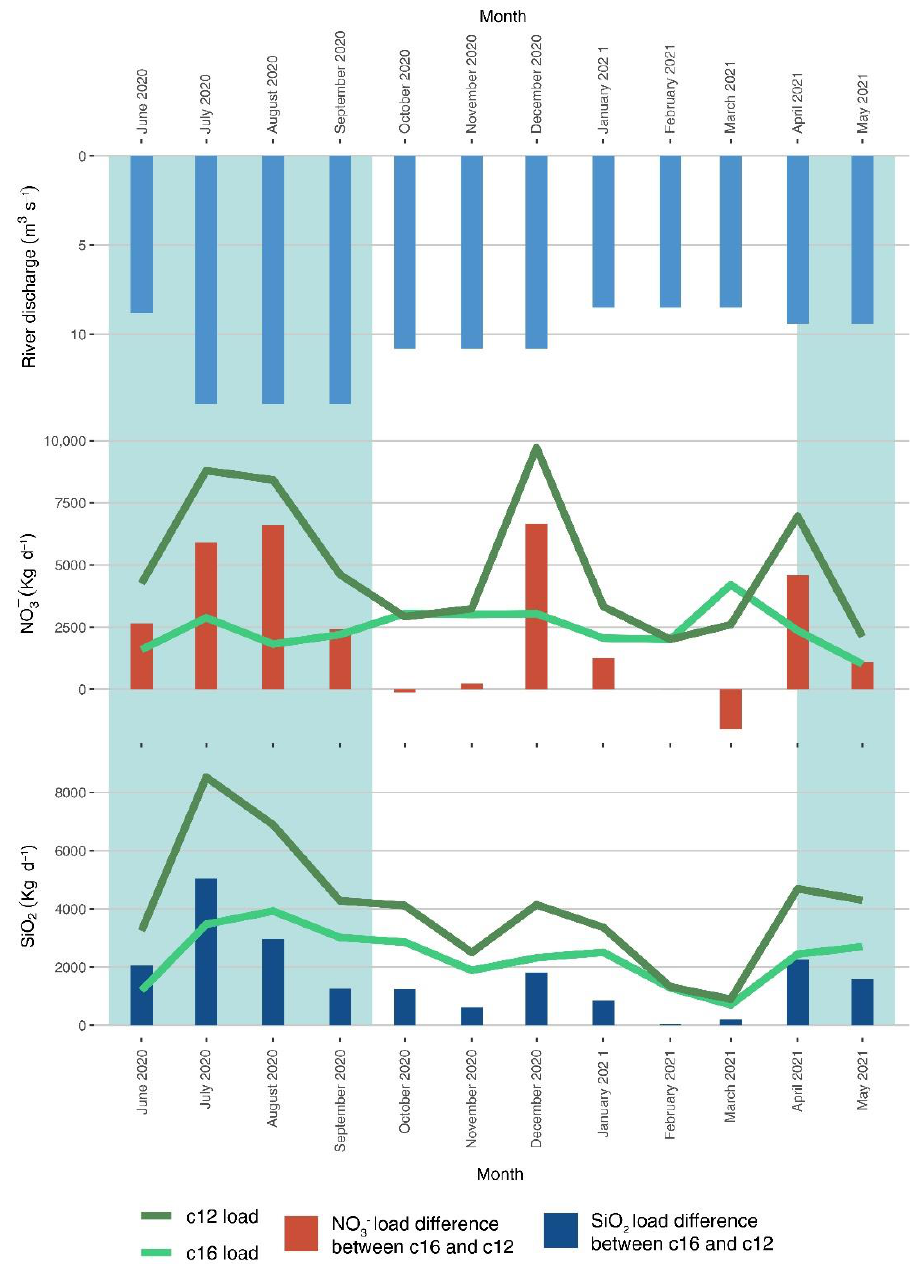
Figure 5. Discharge, NO 3 − , and SiO 2 loads in the Mincio River.